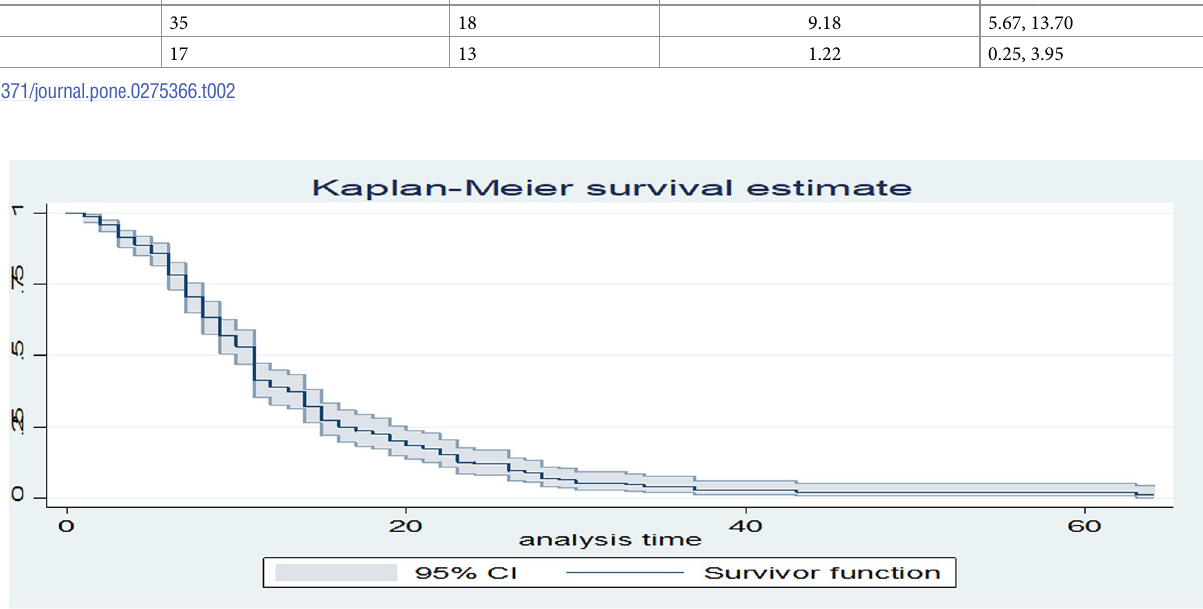
Fig 1. Kaplan-Meier curve of surviving preterm neonates with RDS admitted in NICU at University of Gondar comprehensive specialized hospital from January 2016 to December 2018 (n = 386).